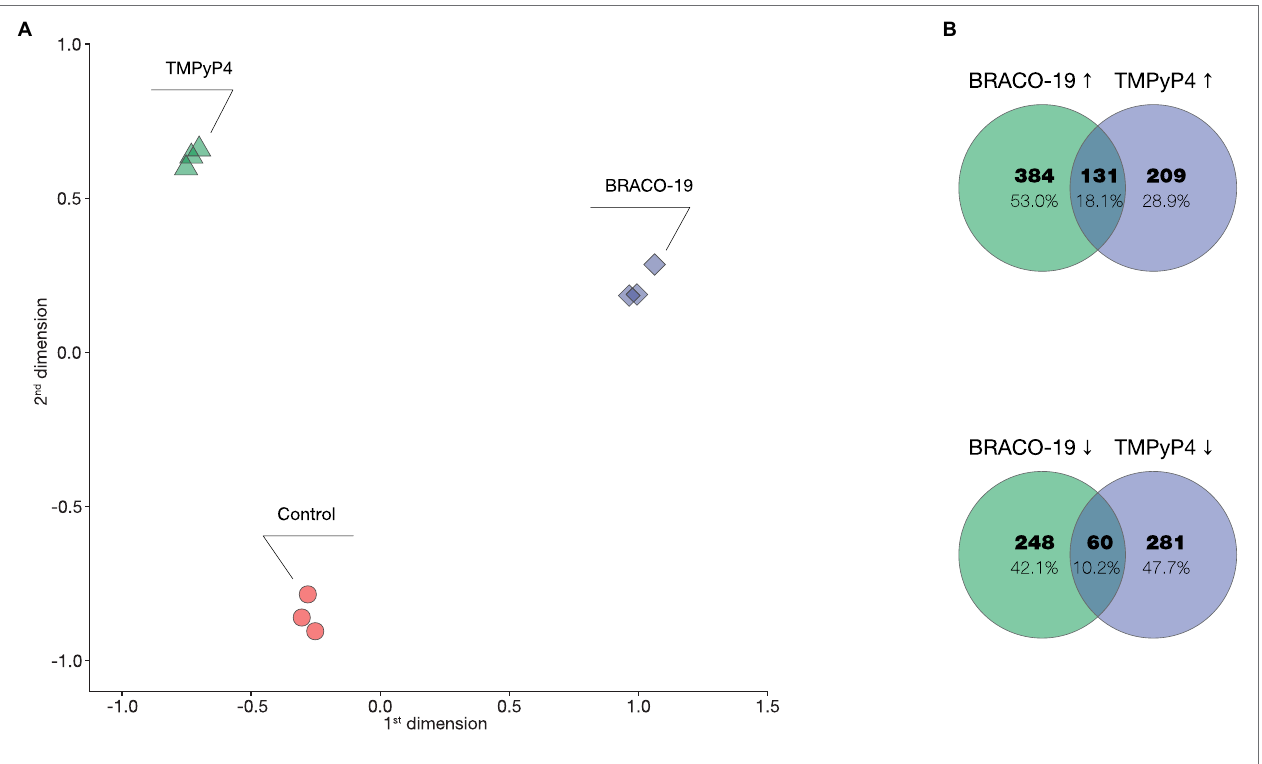
FIGURE 1 | Transcriptional differences between BRACO-19 and TMPyP4 treated Mycobacterium smegmatis samples. (A) , MDS plot of correlation of genes expression levels of three replicate samples (indicated with different colors) across three different conditions; (B) , Venn diagrams showing the genes co-regulated by the presence of BRACO-19 and TMPyP4 compounds, as determined by